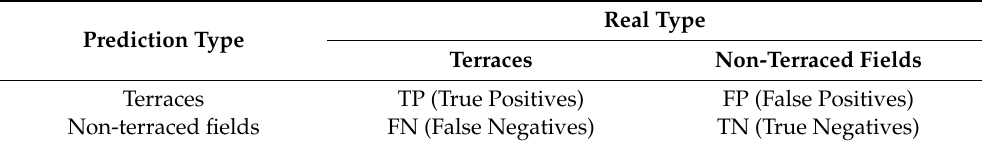
Table 5. Confusion matrix of prediction